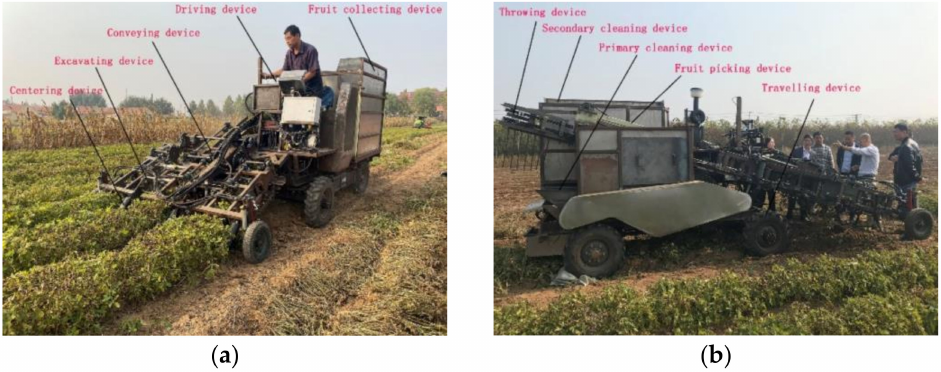
Figure 11. Field trial. ( a ) Front of the machine in working condition; ( b ) Working condition of the side of the